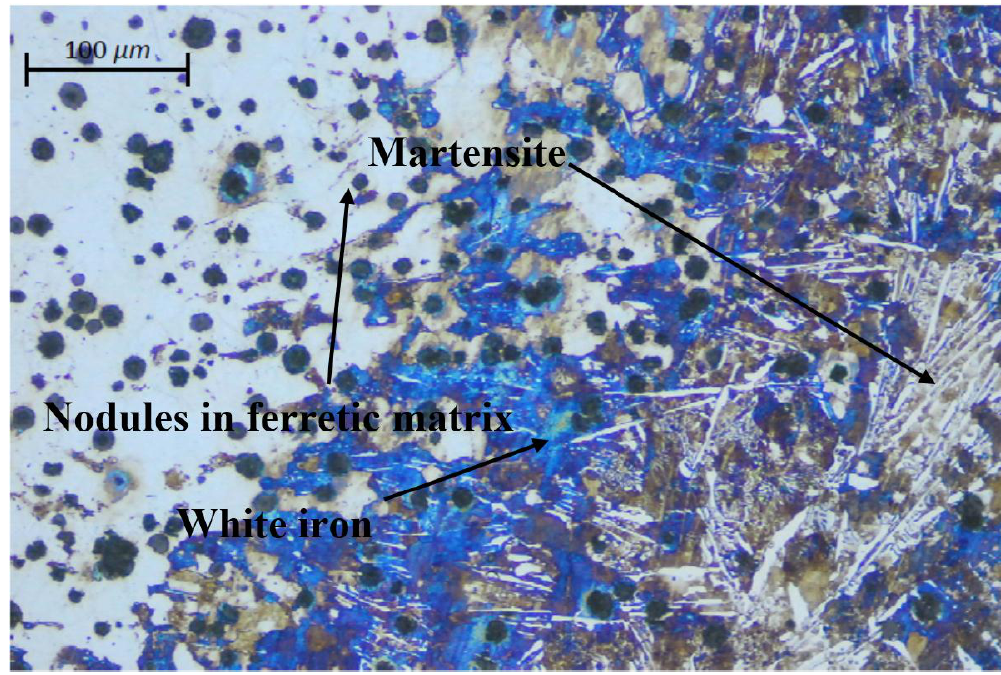
Figure 7. Micrograph of a root weld in ductile iron made with Inconel 625 and subsequent heat treatment at 900°C.